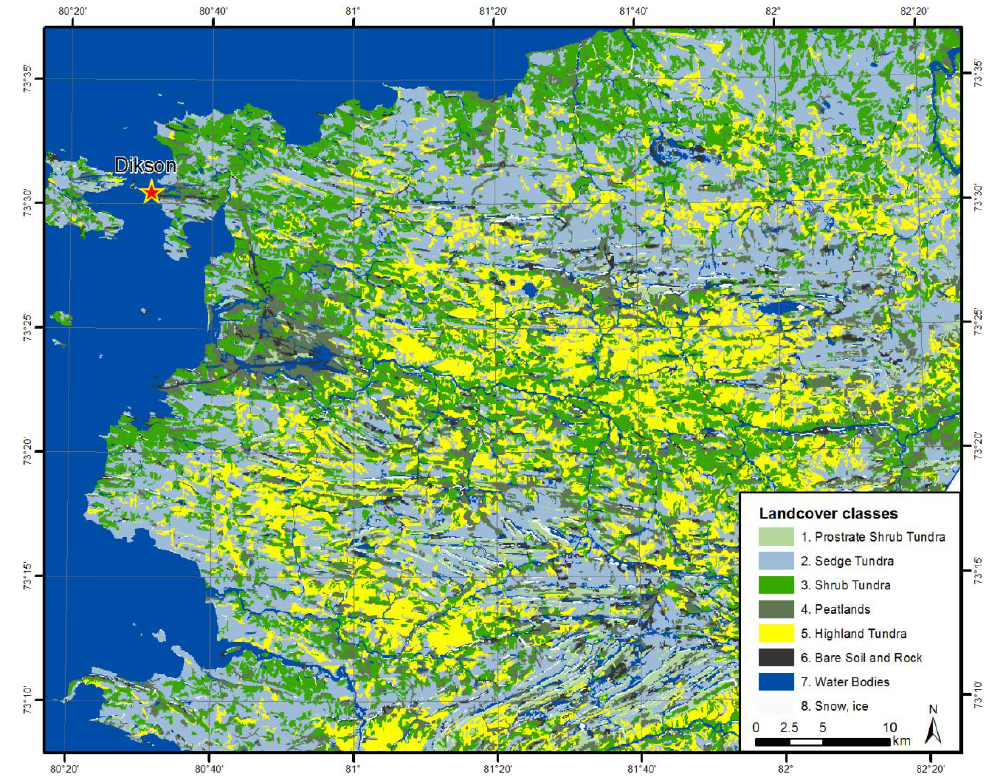
Figure 5. Classification and mapping of the land cover classes for the study area based on the Landsat 8 OLI (18 July 2017) and the Terra Norte RLC vegetation map.